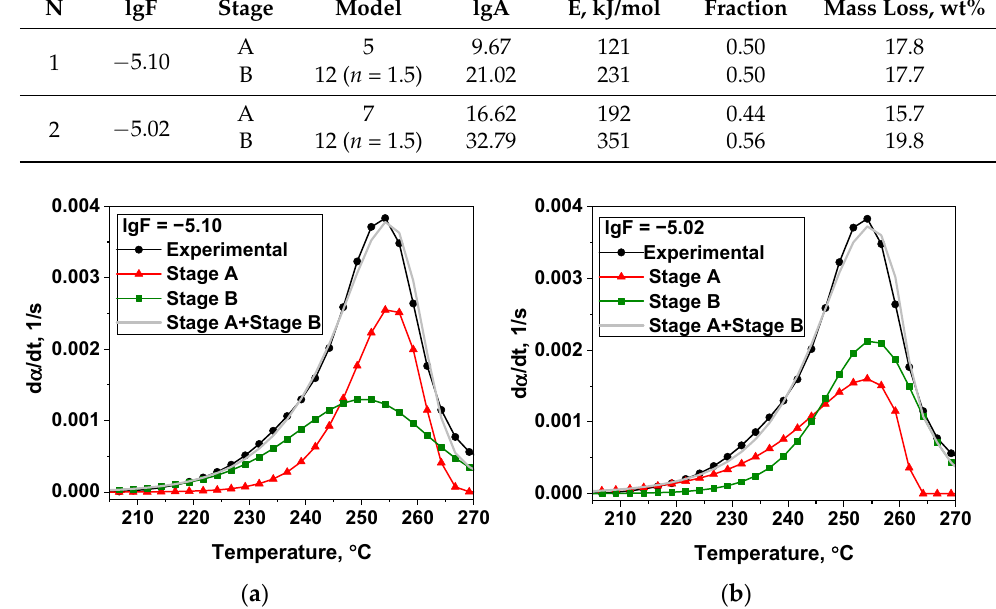
Figure 6. Models of thermal decomposition of [Ni(En) 3 ](ClO 4 ) 2 in helium with β = 5 °C·min − 1 (Table 4): ( a ) variant 1 and ( b ) variant 2 .